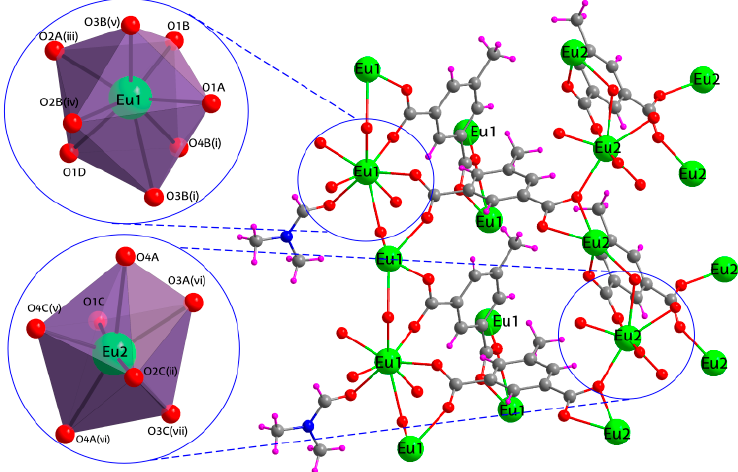
Figure 1. Polymeric structure and coordination polyhedra of compound 2 Eu . Color coding: carbon (grey), nitrogen (blue), oxygen (red), hydrogen (pink) and europium (green).